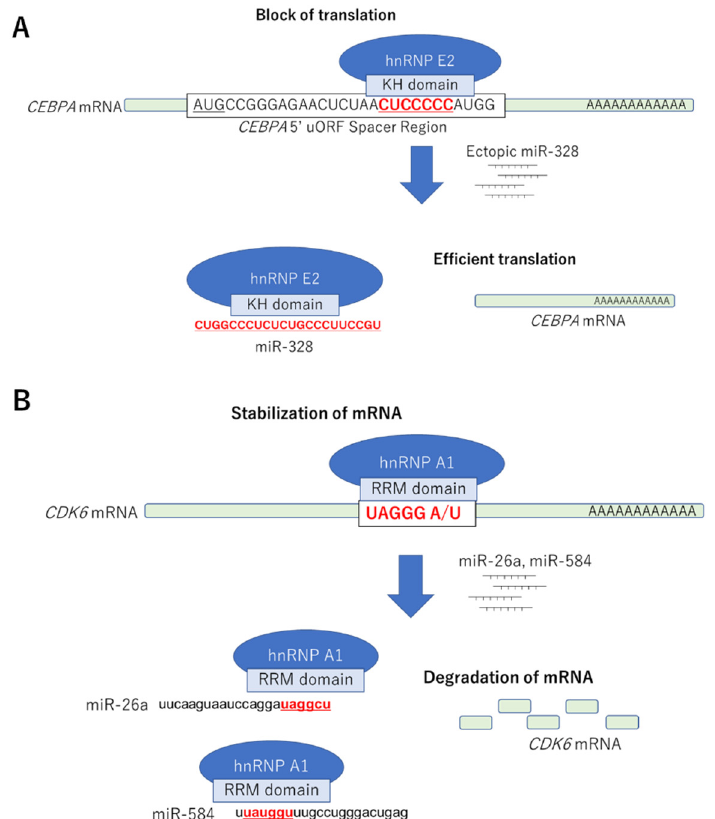
Figure 2. Decoy system mediating miRNA. miR-328 directly binds to the KH domain of hnRNP E2 and inhibits the binding of hnRNP E2 and CEBPA mRNA, thereby accelerating the translation of CEBPA mRNA ( A ). miR-26a and 584 directly bind to the RRM domain of hnRNP A1 and inhibit